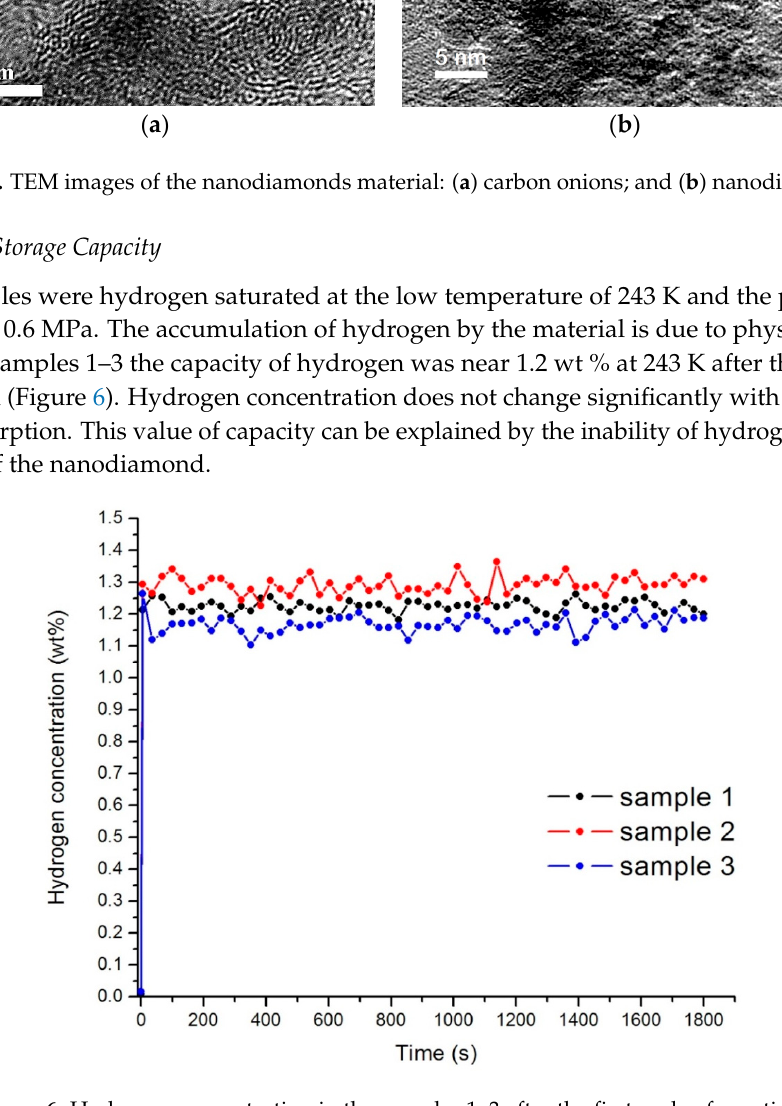
Figure 6. Hydrogen concentration in the samples 1–3 after the first cycle of sorption.